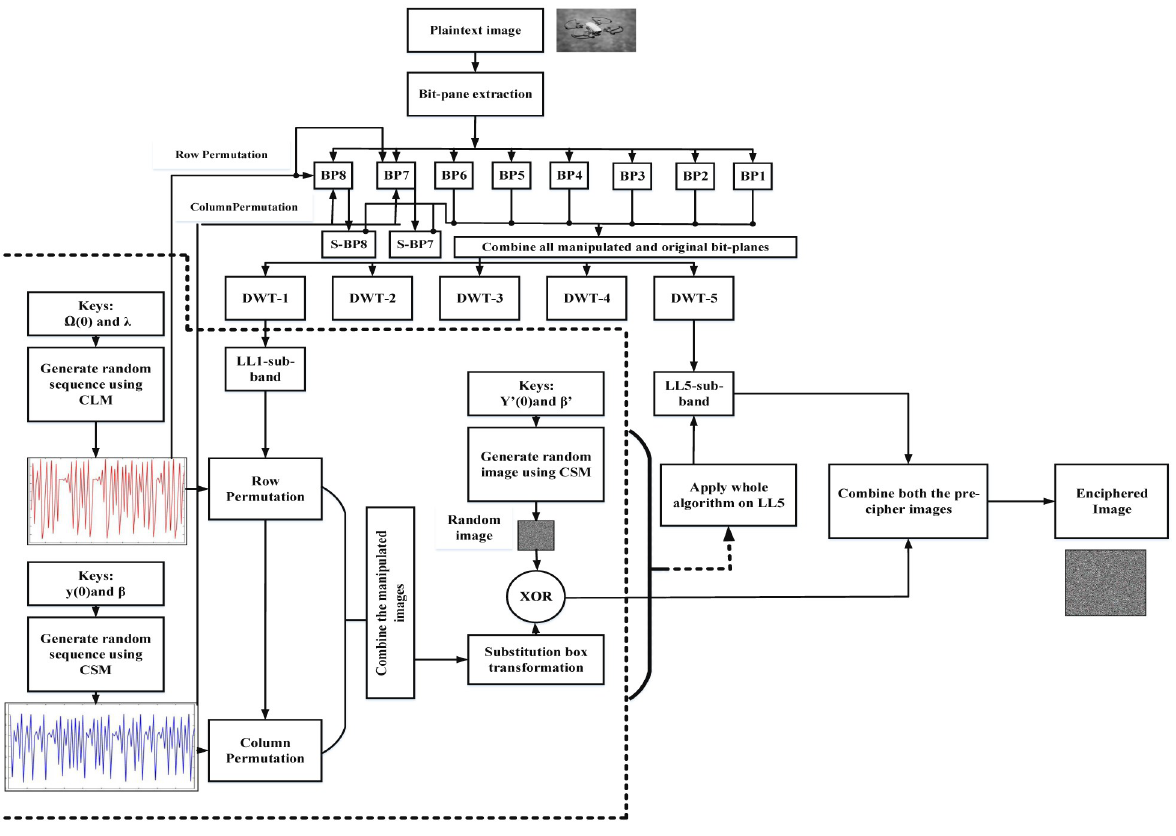
Fig 7. Proposed algorithm for fast image